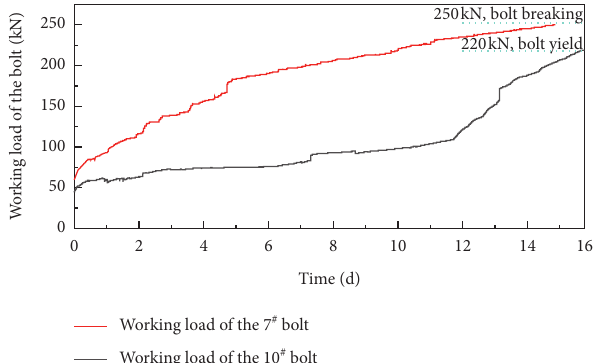
Figure 13: Working load variations of roadway bolts in the extremely thick coal seam under the weak